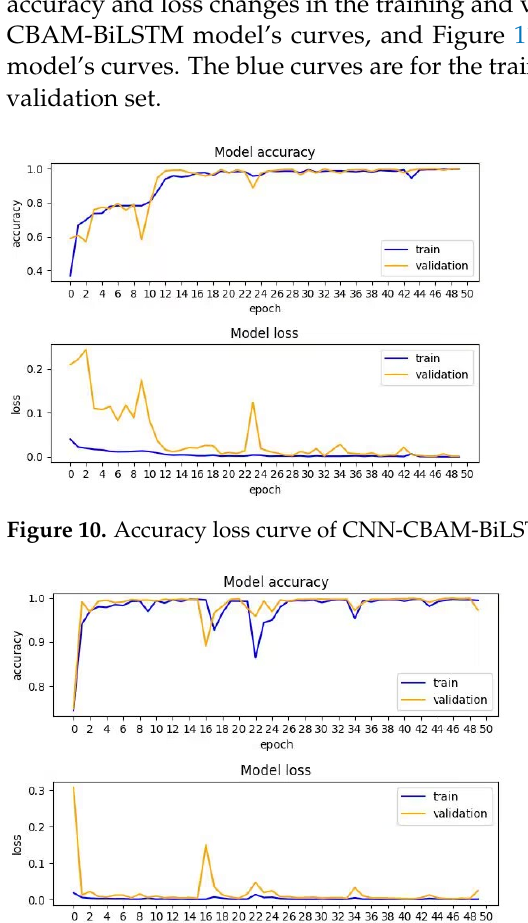
Figure 10. Accuracy loss curve of CNN-CBAM-BiLSTM model.